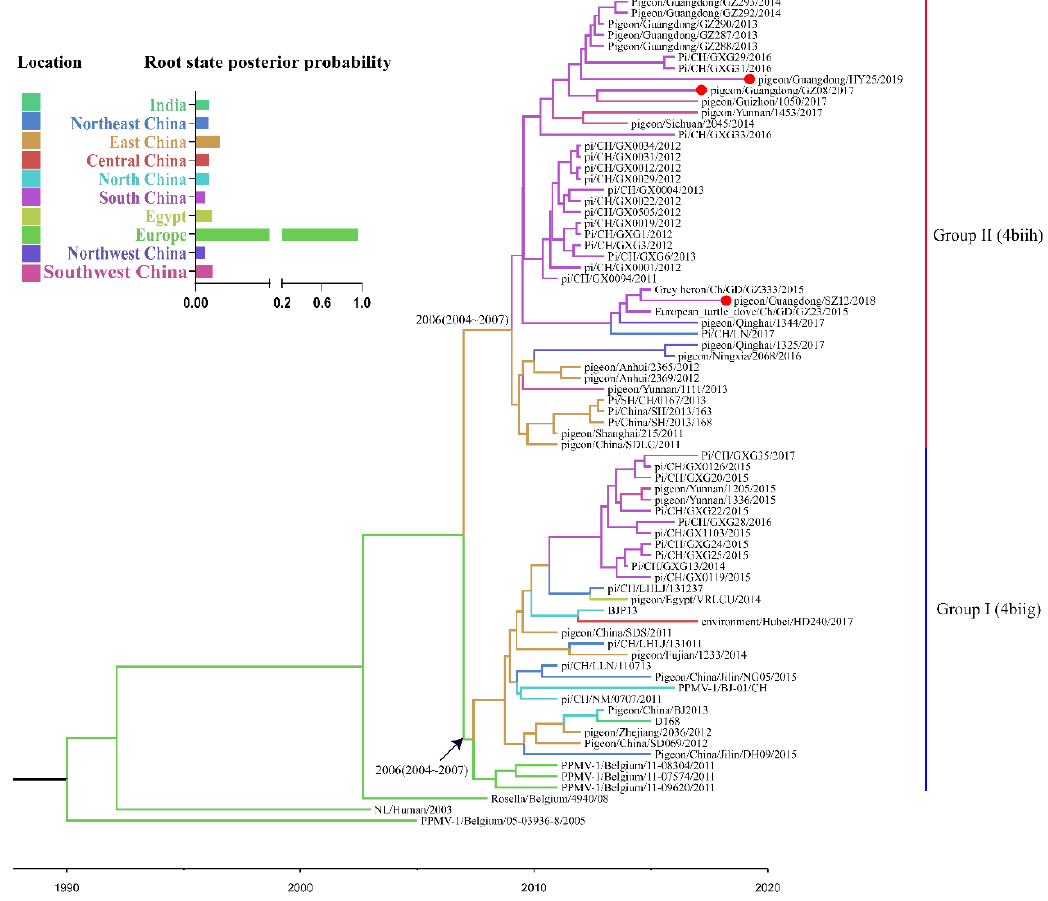
Figure 3. Maximum clade credibility tree of the complete F gene of the sub-genotype VI.2.1.1.2.2 PPMV-1 strains. The tree was constructed using the BEAST version 1.10.4 software. Branch colors denote inferred location states, with the key for colors displayed. The strains from this study are indicated in red solid circles. All VI.2.1.1.2.2 PPMV-1 strains contain 72 isolates available in GenBank as of 31 March 2019, and the three isolates identified in our study. The root state posterior probabilities for the eight regions are shown in the inset panel .